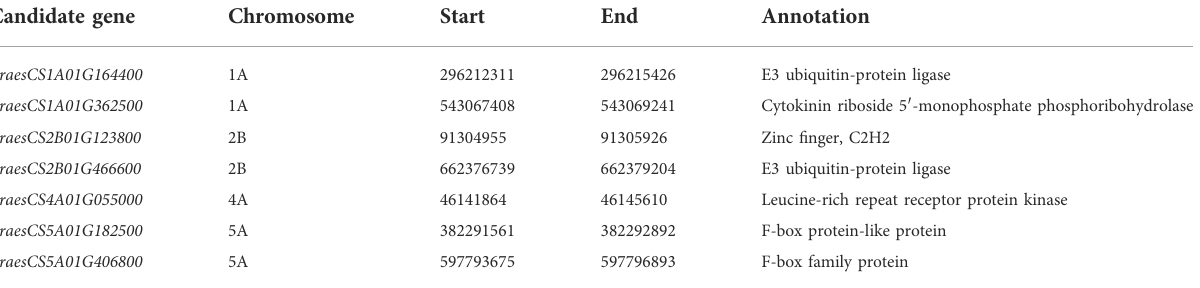
TABLE 3 The details for the candidate genes of morphological